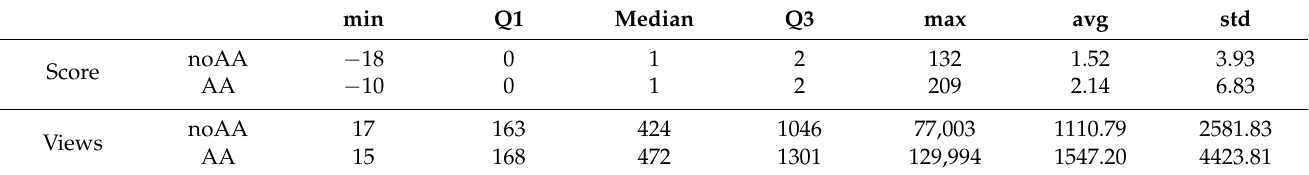
Table 4. Scores and views for questions with accepted answers vs. those without accepted